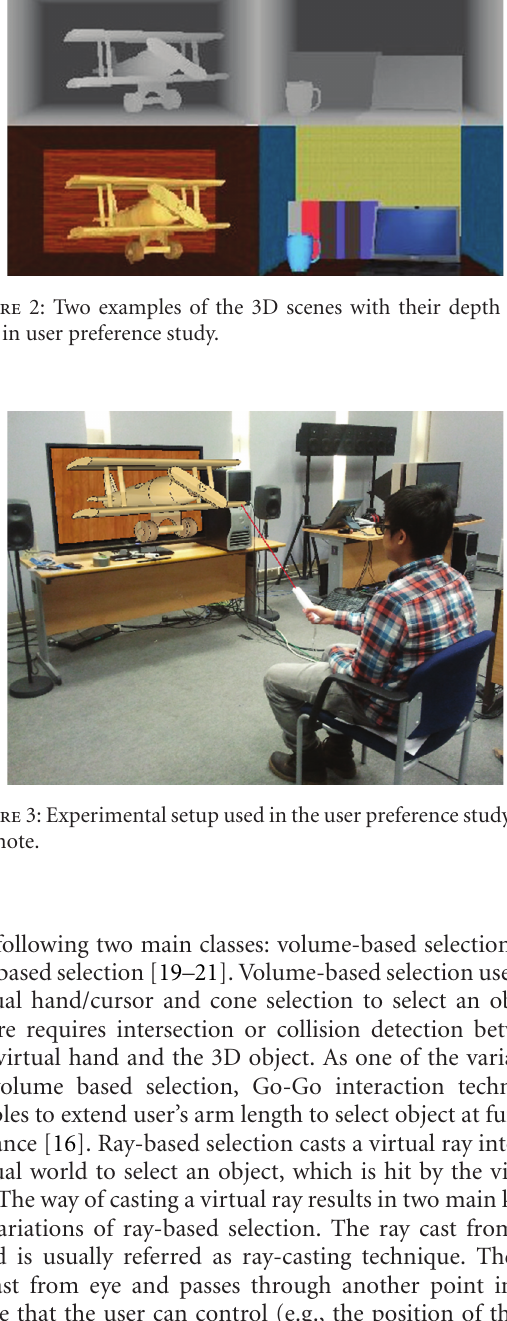
Table 2: Psychographic